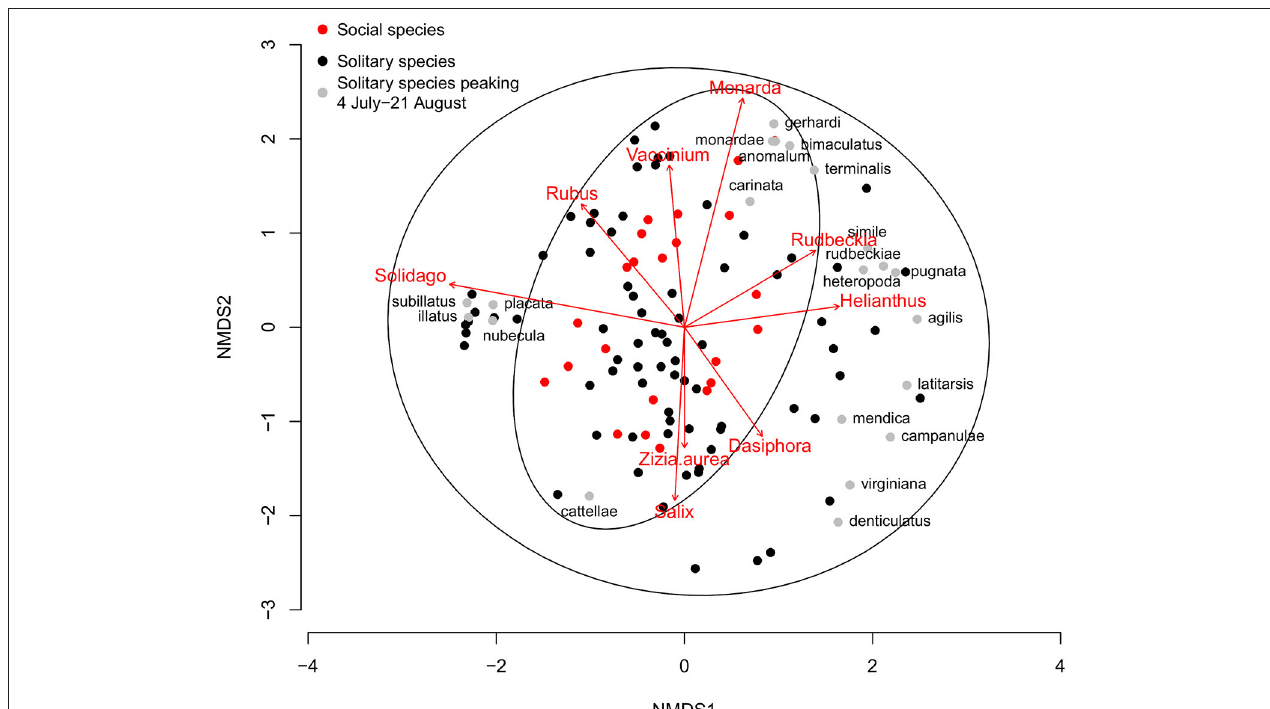
FIGURE 4 | Non-metric multidimensional scaling (NMDS) plot of Michigan native plant pollen diets from wild solitary ( n = 97, black and gray dots) and social ( n = 23, red dots) bee species that have a minimum of five analyzed pollen loads or are well-known specialists. Solitary species that peak in the dearth period between 4 July and 21 August are marked with gray dots with the species epithet ( n = 21, see Table 3 ). Ellipses represent the 95% confidence intervals for the solitary and social groupings. Arrows represent those plant pollens that are significantly correlated with specialized bee diets. For clarity, only plant groups that are significant at p < 0.01 are plotted, with the length of the arrow corresponding to the strength of the relationship.